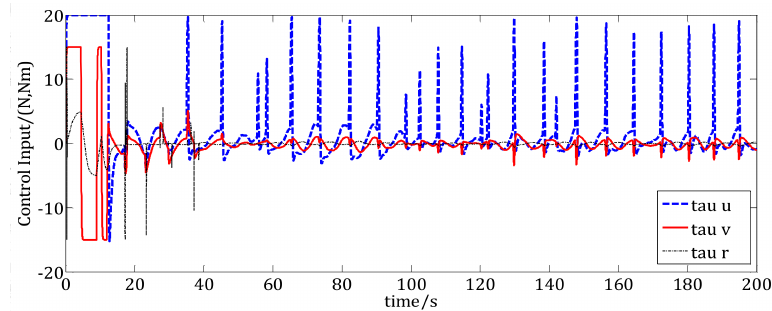
Figure 15. Control inputs of the USV under the traditional the